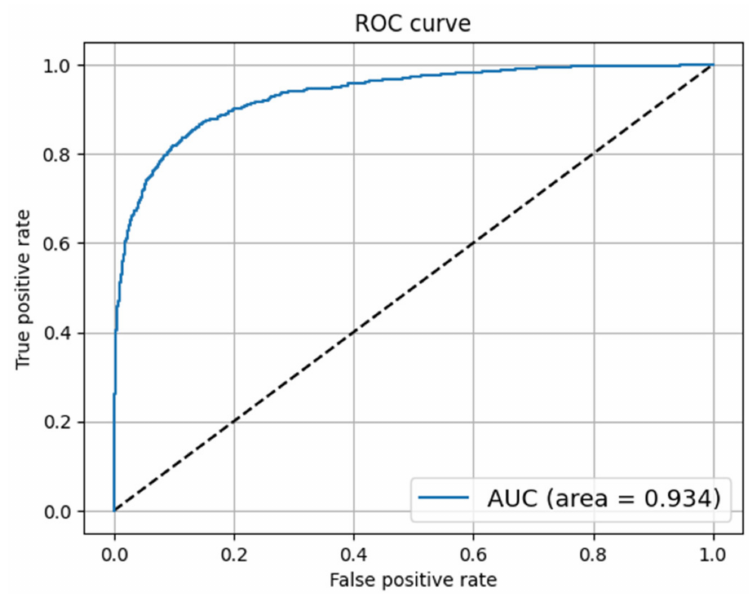
Figure 7. ROC curve of LSTM on Constraint@AAAI 2021